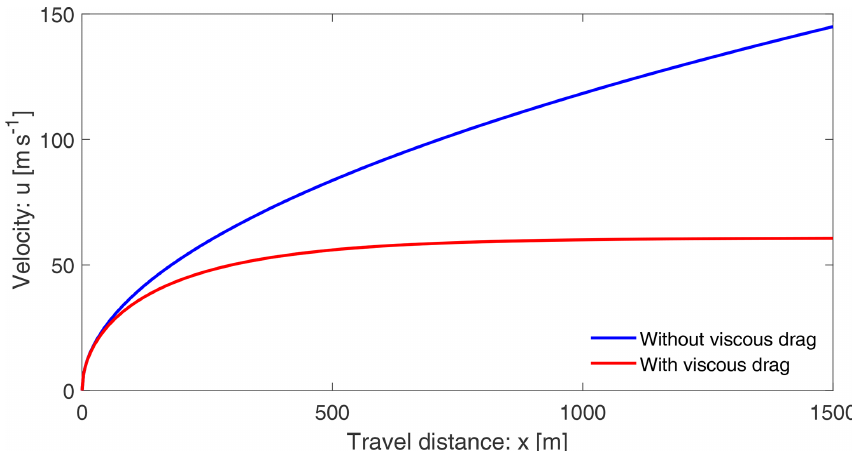
Figure 1. The landslide velocity distributions down the slope as a function of position both without and with drag given by Eqs. (7) and (8), respectively. With drag, the flow attains the terminal velocity u Tx ≈ 60 . 1ms − 1 at about x = 600m, but without drag, the flow velocity increases